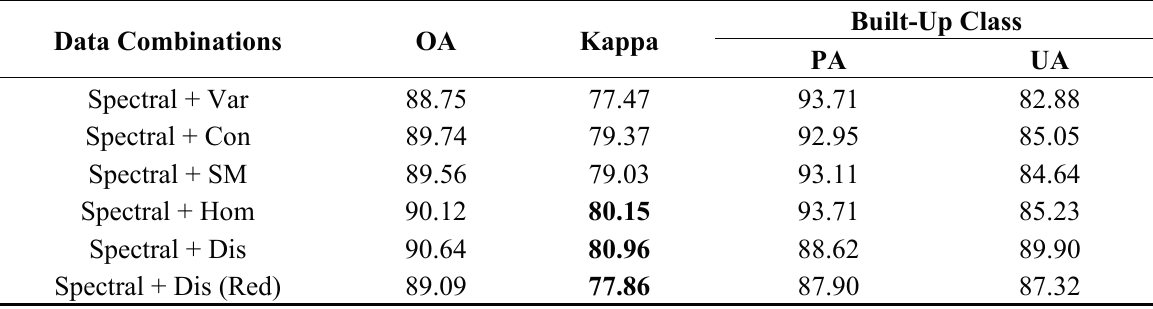
Table 3. Classification accuracies using multispectral data and selected gray-level co-occurrence matrix (GLCM) textures for a 2005 image of the Beijing area (all in %). Data Combinations